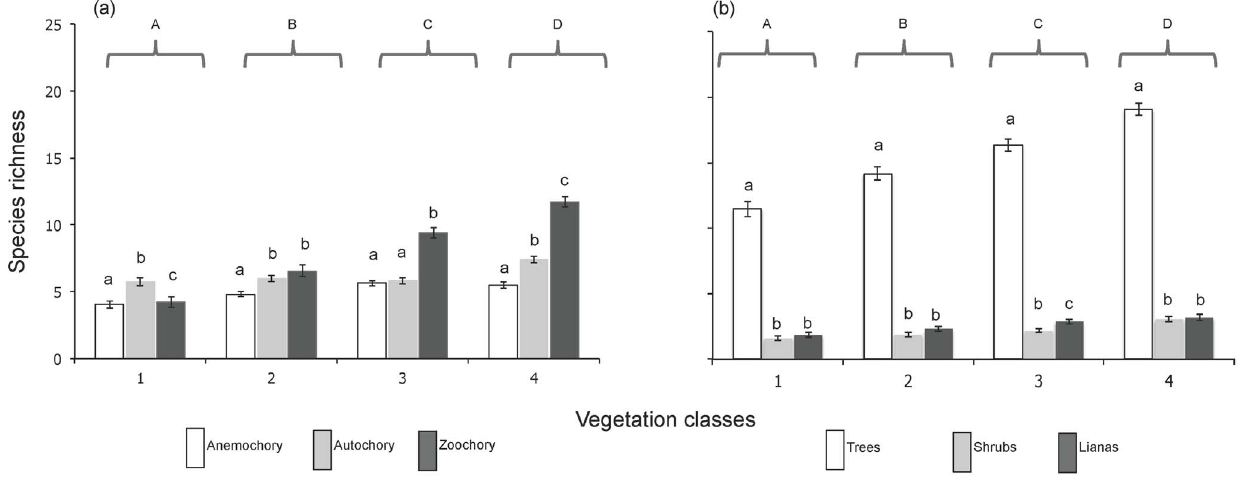
Figure 2. Differences in species richness by functional group among vegetation classes (upper-case letters) and among functional groups (lower-case letters). Different letters represent significant differences ( P , 0.001).